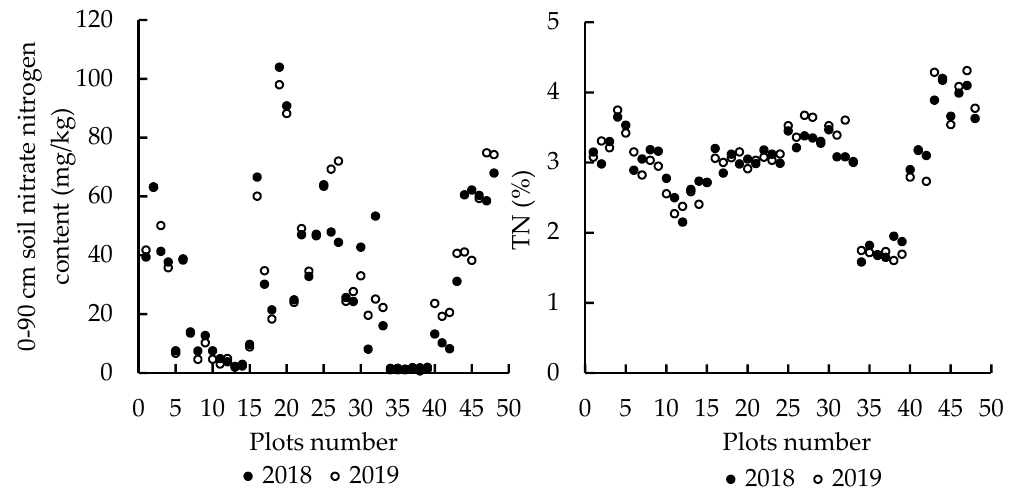
Figure 4. The distribution of TN of winter wheat and 0–90 cm soil nitrate nitrogen content in different fertilizer level experimental plots (2018 and 2019).